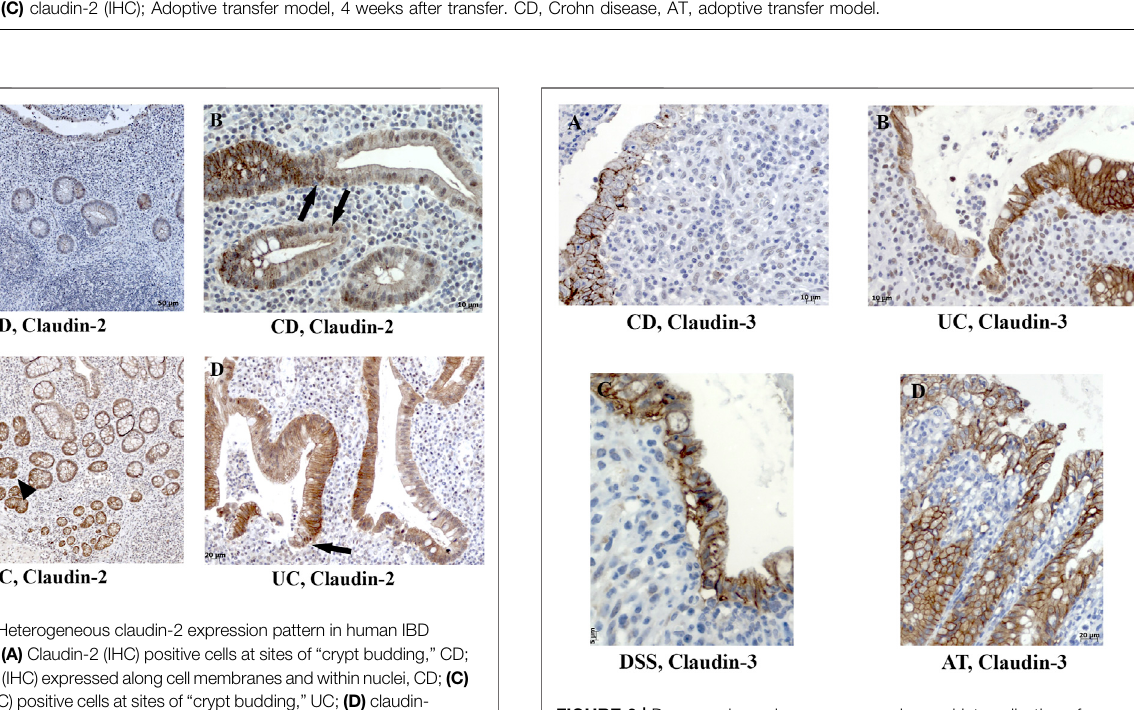
FIGURE 6 | Decreased membranous expression and internalization of claudin-3incolontissue ofIBDpatients and IBDanimalmodels. (A) Claudin-3 (IHC), CD; (B) claudin-3 (IHC), UC; (C) claudin-3 (IHC), DSS; (D) claudin-3 (IHC), adoptive transfer model, 8 weeks after transfer. CD, Crohn disease; UC, ulcerative colitis; AT, adoptive transfer